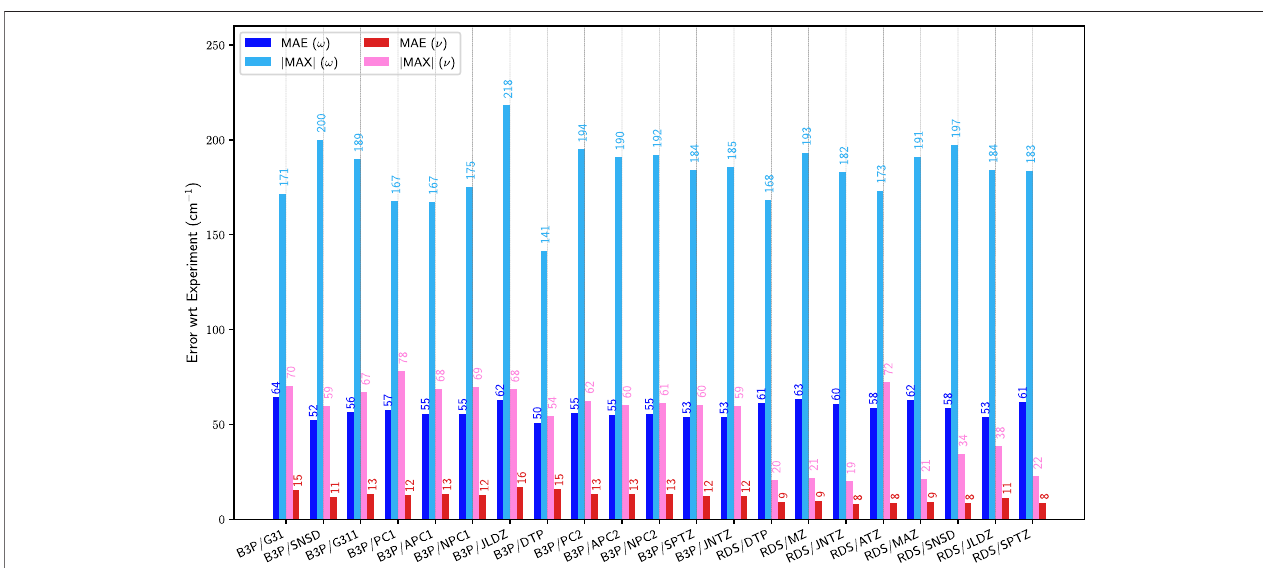
FIGURE 3 | Comparison of the mean (MAE) and maximum absolute (|MAX|) errors at the B3PW91 ( B3P ) and revDSD-PBEP86-D3(BJ) ( RDS ) levels with different basis sets over the fi rst set of molecules (G1). G31 : 6 – 31+G(d), SNSD : SNSD, G311 : 6 – 311++G (3df, 3pd), PC1 : PC-1, APC1 : aug-PC-1, NPC1 a : naug-PC-1, JLDZ : jul-cc-pVDZ, DTP : def2-TZVP, PC2 : PC-2, APC2 : aug-PC-2, NPC2 b : naug-PC-2, SPTZ : spaug-cc-pVTZ, JNTZ : jun-cc-pVTZ, ATZ : aug-cc-pVTZ, MZ c : M-cc-pV [T+Q]Z, MAZ d : M-aug-cc-pV[T+Q]Z. ω (blue) corresponds to the harmonic approximation, ν (pink/red) to GVPT2. The values are indicated on top of the bars. See Figure2 fordetailsonthereferencedata. (a) :basissetbuiltfromaug-PC-1Jensen(2001),byremovingthe d diffusefunctions. (b) :basissetbuiltfromaug-PC-2Jensen (2001),byremoving the d and f diffusefunctions. (c) :basissetbuiltbycombining s and p basisfunctionsfromcc-pVQZ,and d and f fromcc-pVTZ. (d) :basissetbuiltby combining s and p basis functions from cc-pVQZ, and d and f from cc-pVTZ, augmented with d diffuse functions on all atoms except for H.